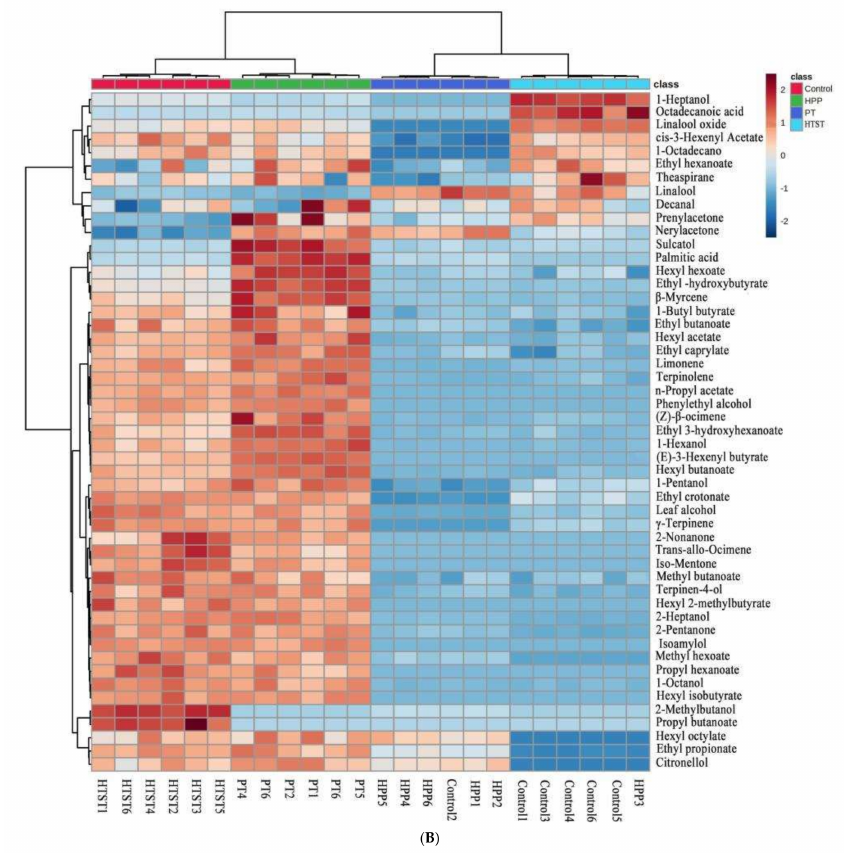
Figure 1. ( A ) Concentrations of major classes of aroma compounds of control, high-pressure pro- cessing (HPP), pasteurization (PT), and high-temperature short time (HTST)-treated passion fruit pur é e; ( B ) hierarchical clustering of the 51 quantified aroma compounds in control-, HPP-, PT-, and HTST-treated passion fruit pur é